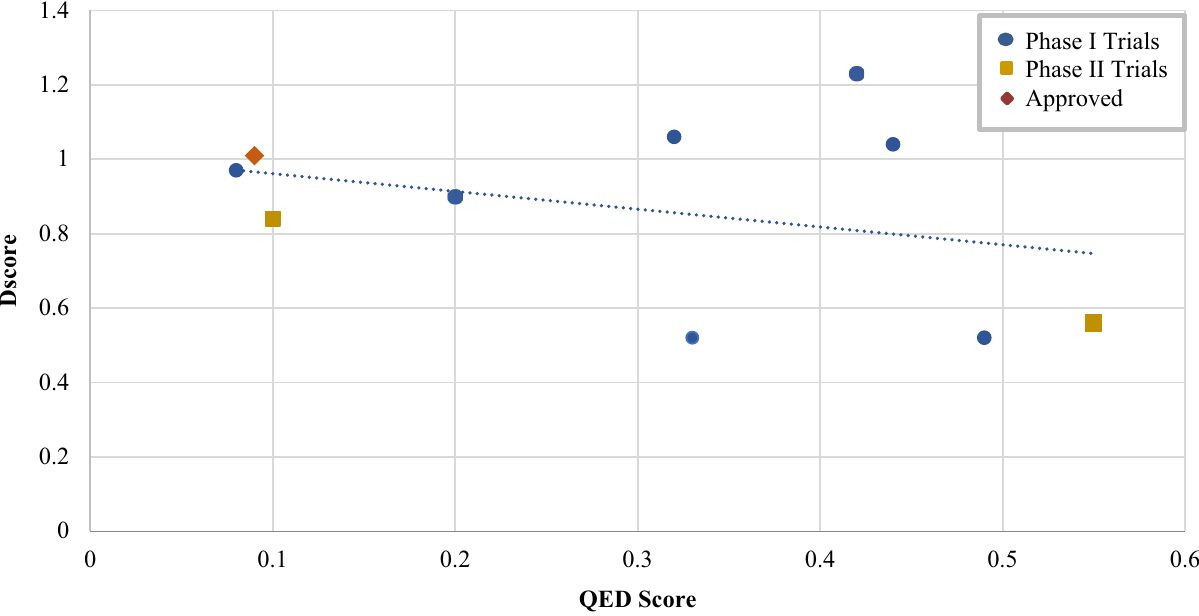
Figure 9. Distribution of QED scores of small molecule orally tested/approved PPI drugs relative to the druggability scores (Dscore) of identified binding